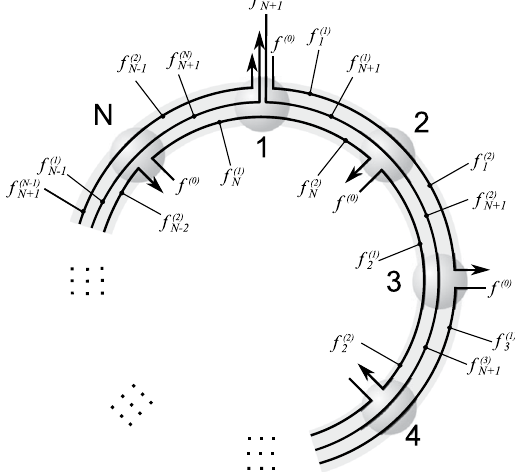
Figure 5. Ring lattice with N nodes and edges, such that each edge has capacity c , with paths and nodes indexed clockwise from the top. Short paths inject a flow f (0) at each node and use the network for two edges before (0) at node 1 and uses all edges of the network. If we distribute edge exiting, and a long path injects a flow f + N 1 capacity proportionally to flows entering the edge, the network throughput goes to zero as the flow injected at each node increases, because queues of increasing length build up at each